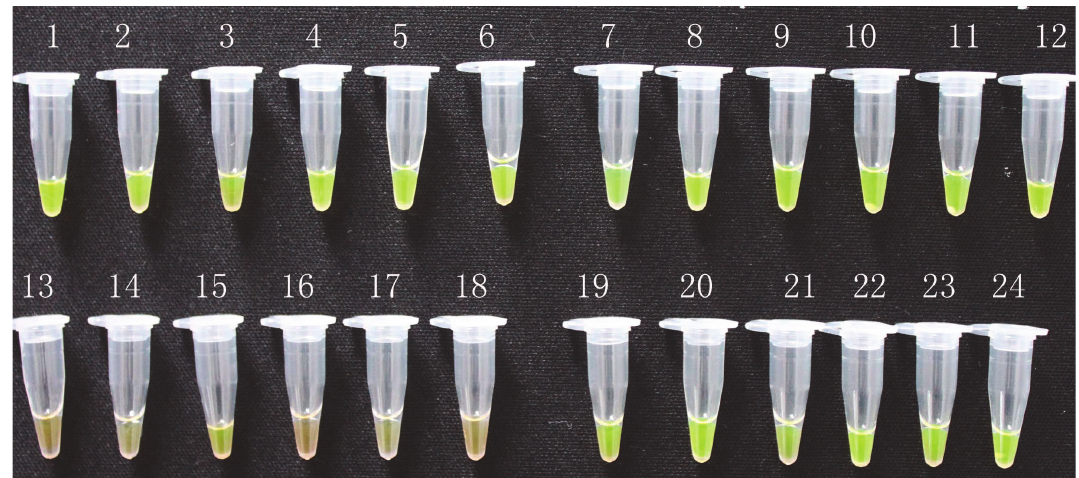
Figure 1: Optimal reaction condition and primers used in the LAMP assay. Amplified products were judged by color change. A positive reaction was indicated by a color change from orange to green. Tubes: 1–6, primers set 1 (60 ∘ C–65 ∘ C); 7–12, primers set 2 (60 ∘ C–65 ∘ C); 13–18, primers set 3 (60 ∘ C–65 ∘ C); 19–24, primers set 4 (60 ∘ C–65 ∘ C). The color of the primers of set 2 was greener than that of the others, especially at 62 ∘ C.